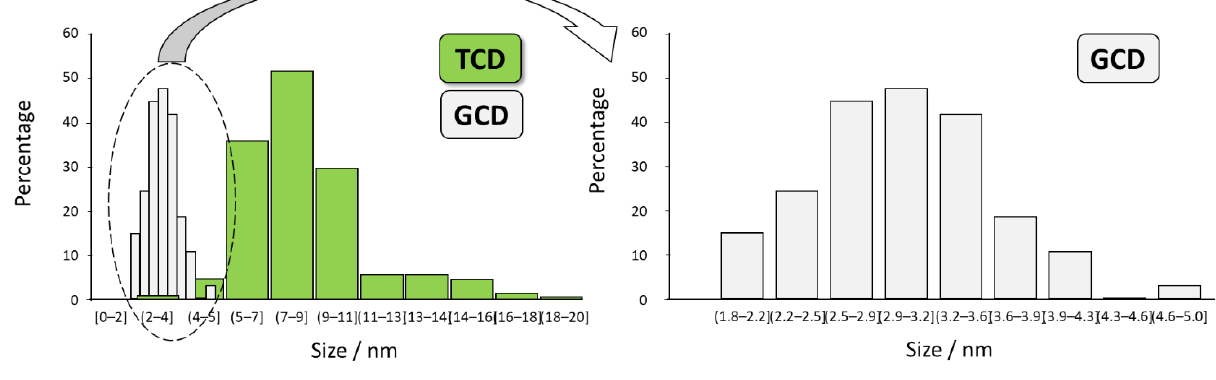
Figure 2. Size distribution histogram ( left ) TCD ( right ) GCD.